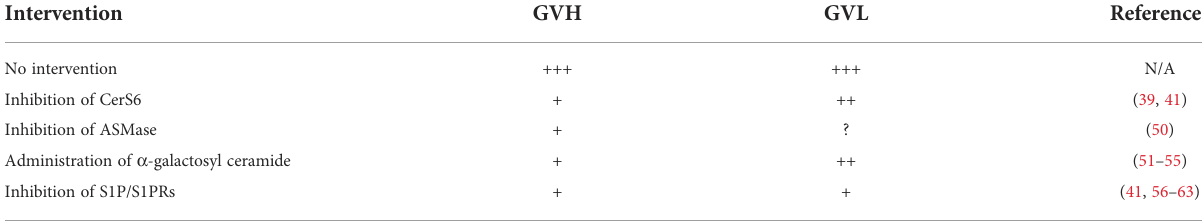
TABLE 1 The impacts of targeting sphingolipids in GVH and GVL responses after allo-HCT.